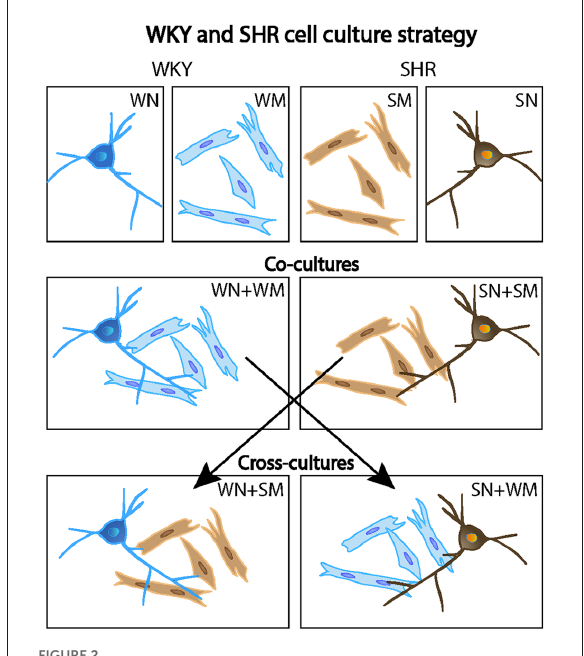
FIGURE2 Mixed co-culture experimental design. Primary cultures of WKY and SHR were grown alone (top row: WN, WKY neurons only; WM, WKY cardiomyocytes only; SM, SHR cardiomyocytes only; and SN, SHR neurons only). In some experiments, co-cultures of neurons and cardiomyocytes from the same rat strain were used (middle row: WN + WM, WKY neurons, and WKY cardiomyocytes and; SN + SM, SHR neurons and SHR cardiomyocytes). Cross- cultures conditions mixed neurons and cardiomyocytes from the two different strains (bottom row: WN + SM, WKY neurons, and SHR cardiomyocytes and; SN + WM, SHR neurons, and WKY cardiomyocytes. This cell culture strategy allowed analysis of strain-specific contributions of individual cell types to neuronal activity and cardiomyocyte